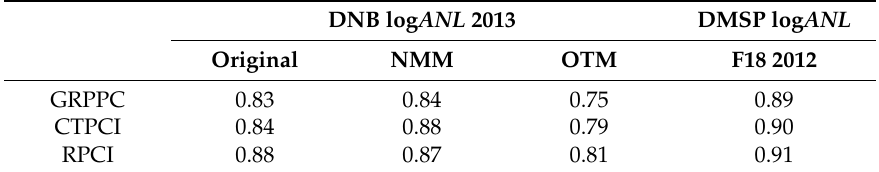
Table 7. Correlation coefficients between log ANL and socio-economic parameters. log ANL ’s are derived from DNB composite data with or without noise filtering and DMSP-OLS stable data, respectively.